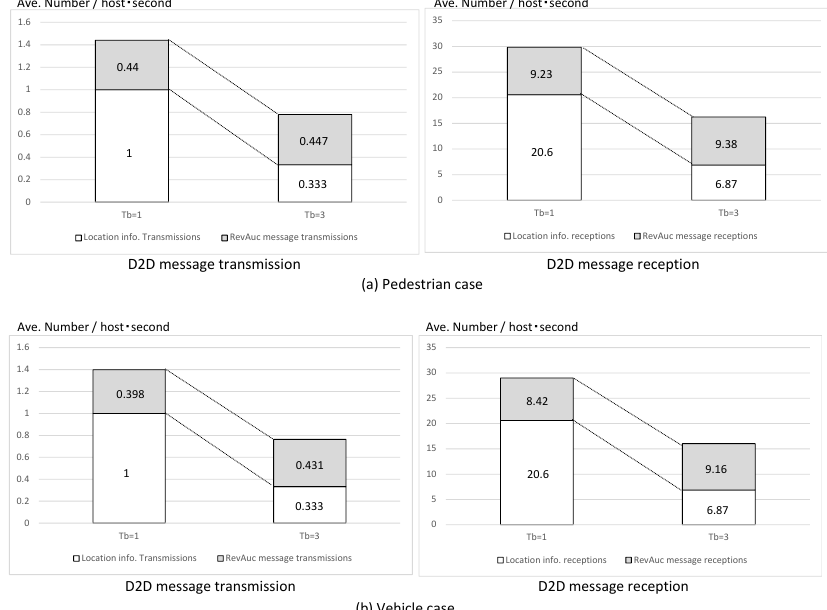
Figure 20. Number of D2D messages.